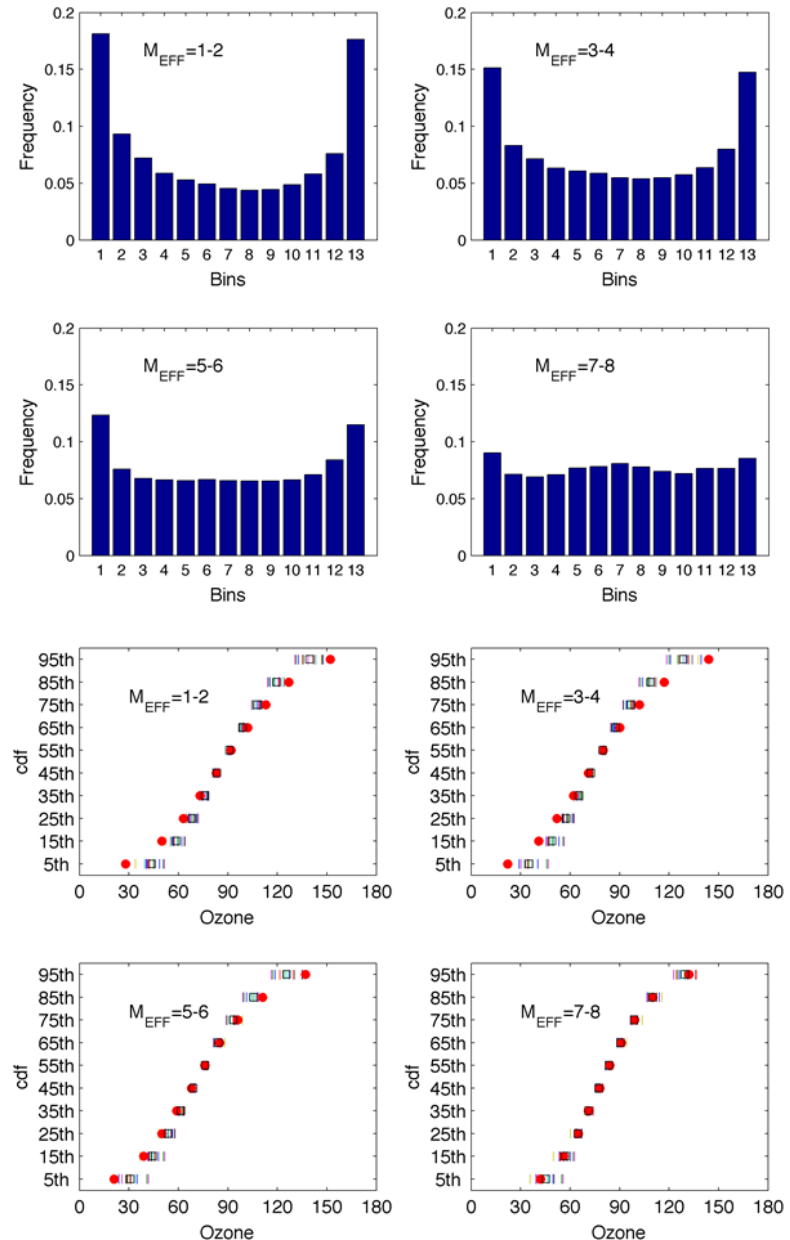
Figure 12. Top: Talagrand diagram of the full ensemble aggregated at the stations as a function of M eff . Bottom: cumulative density function of observations (red circle) and models (coloured lines), aggregated at the stations as a function of M eff . The ensemble mean is displayed with a